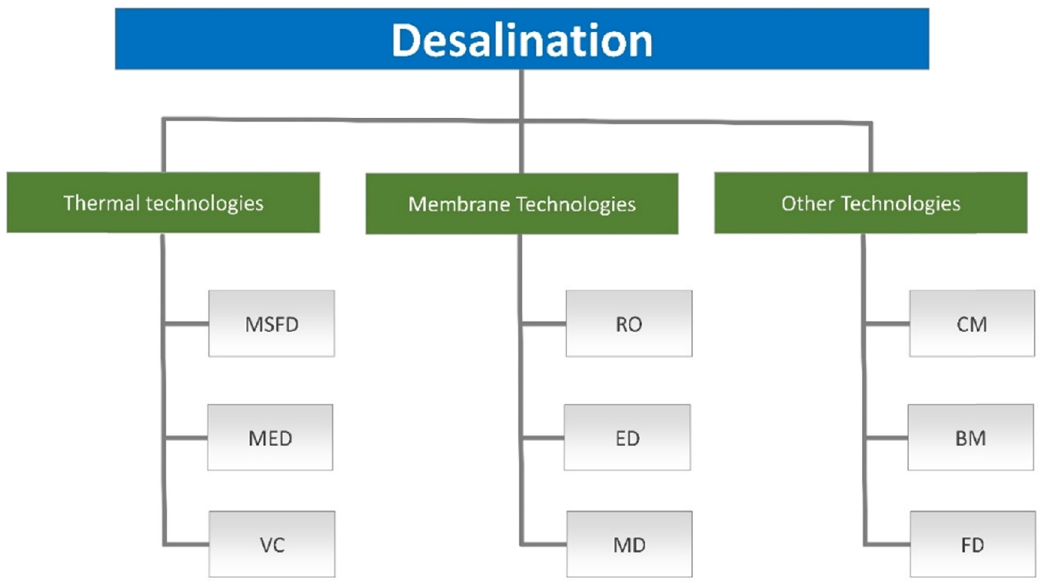
Figure 2: Classi fi cation of the widely used desalination techniques. MSFD, MED, vapor compression, RO, ED, MD, CM ( chemical methods ) , BM ( biological methods ) , and FD ( freezing distillation )